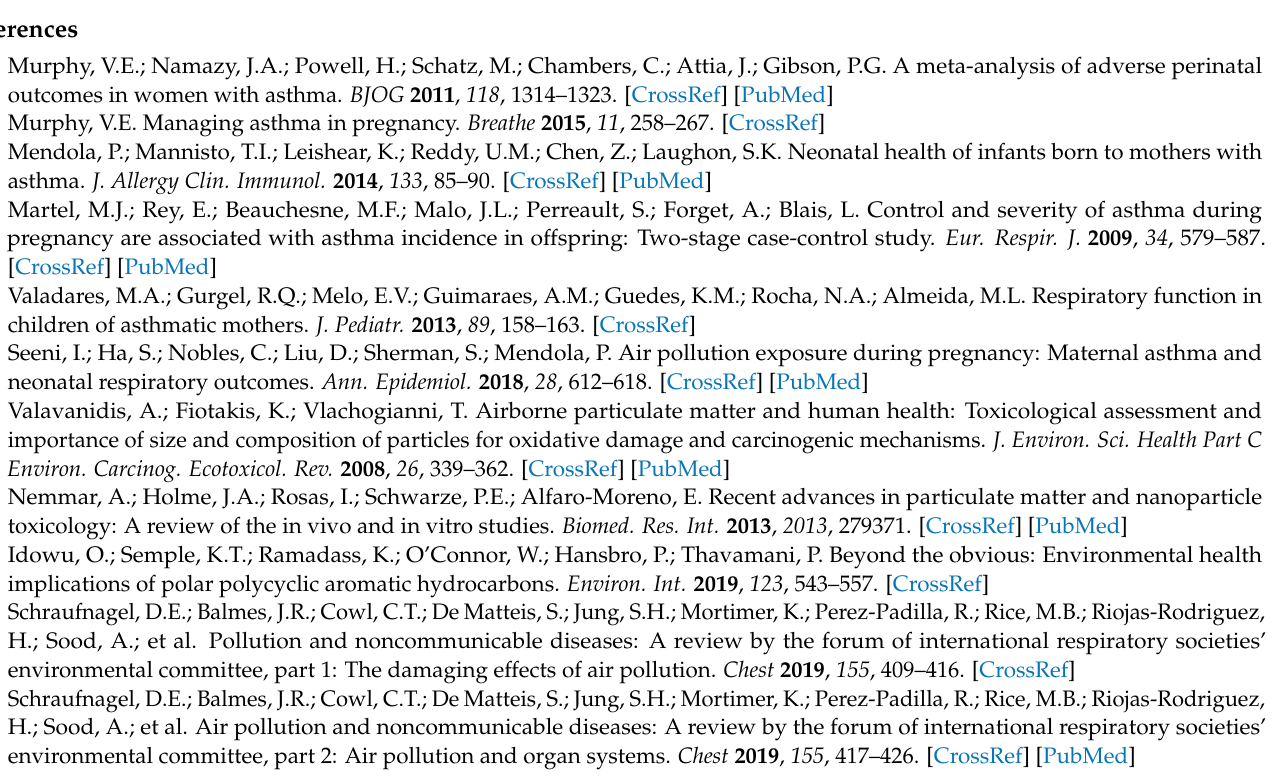
FACS, fluorescence-activated cell sorting, Figure S2: Component loadings (A) and score variables (B) from the PCA (air pollutant) analyses, Figure S3: Component loadings from the PCA (cell type) analyses, Figure S4: Score variables from the PCA (cell type)